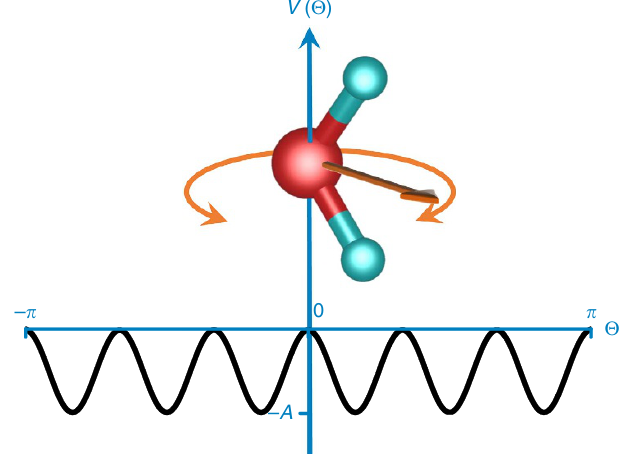
Figure 6 | Rotation of the water molecule. Squared cosine potential V ( y ) ¼ (cid:2) A (cid:3) cos 2 3 y ( A 4 0) used to model the dynamics of interacting type I water molecules located within the cages of hexagonal beryl crystal lattice. The molecules can rotate around the crystallographic c axis. They rotate freely at temperatures well exceeding the potential energy barriers (T 44 A/k B ), but can only librate within one minima or tunnel between the minima at low temperatures ( T oo A/k B